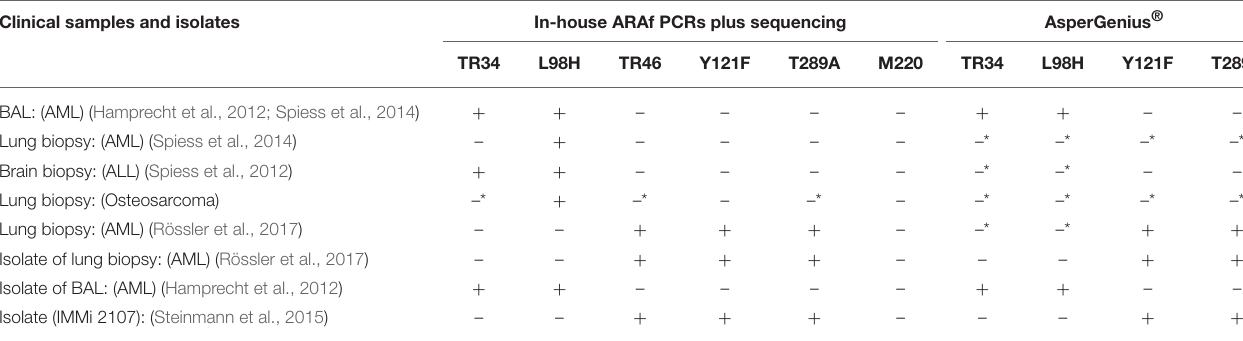
TABLE 3 | Summary of all detected Cyp51A mutations from clinical samples and isolates so far. Clinical samples and isolates